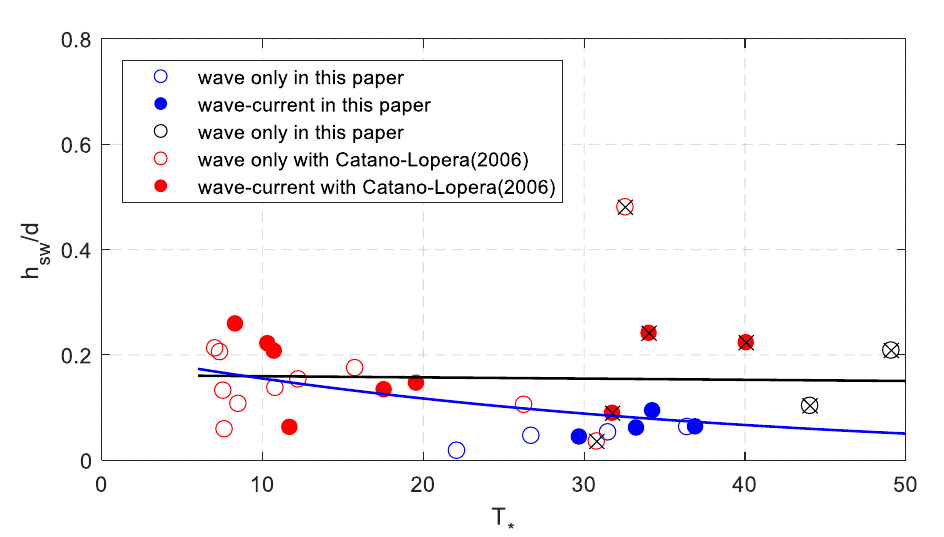
Figure 7. The relationship between the measured dimensionless sand wave height and dimensionless shear stress. The blue circles represent the results of experiments of this paper with a medium diameter of 0.17 mm and the dark ones of 0.18 mm. The red circles represent the results of experiments conducted by Cataño-Lopera et al. [1]. The range of the dimensionless shear stress is about 7–49.